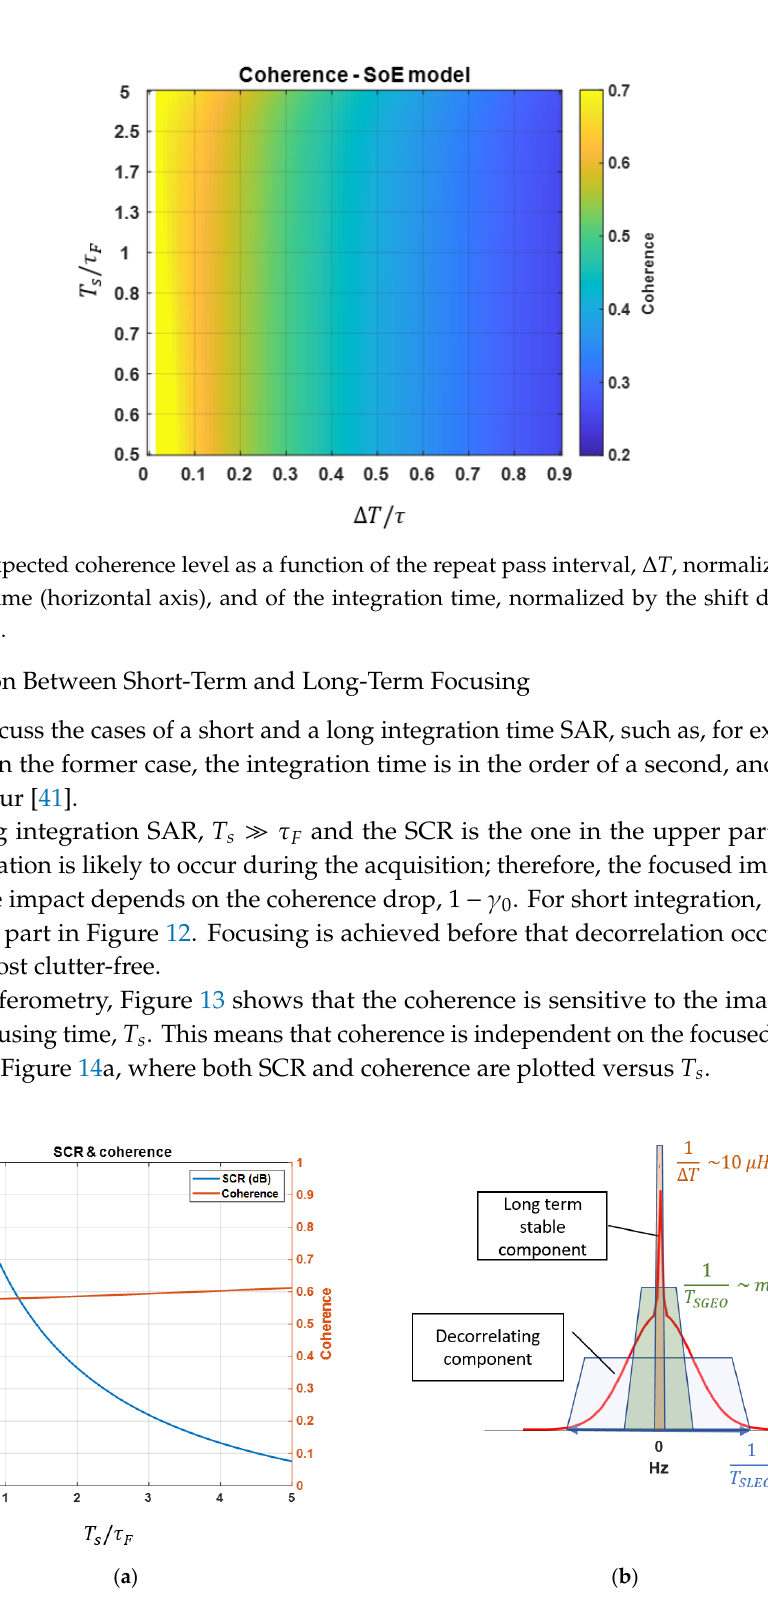
Figure 14. ( a ) Comparison between SCR and interferometric performances for the SoE decorrelation, as a function of the ratio between the focusing time and the fast decay time. Notice that coherence is mostly insensible to that. ( b ): Sketch of the scene power spectrum (red line), compared with the bandwidth of an LEO SAR (blue), a Geosynchronous Equatorial Orbit (GEO) SAR (green) and the one of the interferometric signal (orange), 1/Δ t .